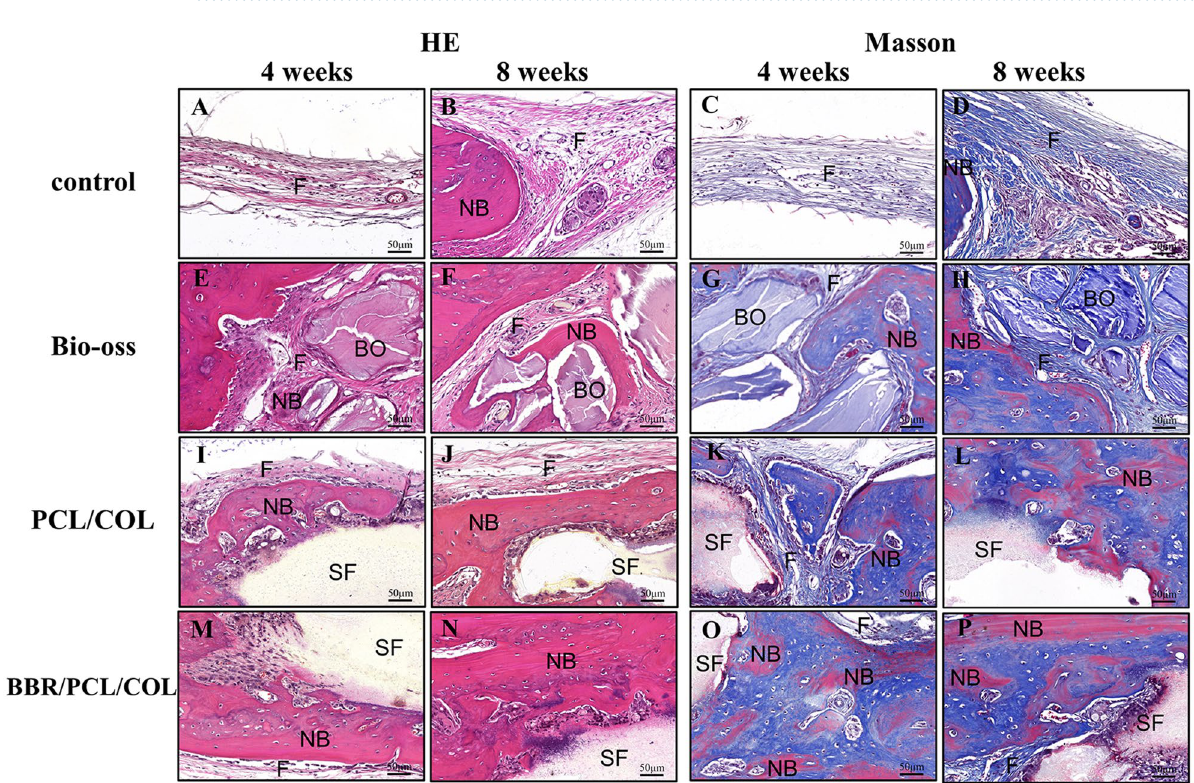
Figure 8. H&E and Masson staining of defects at higher magnification. F, fibrous tissue; BO, Bio-oss; NB, new bone; SF,